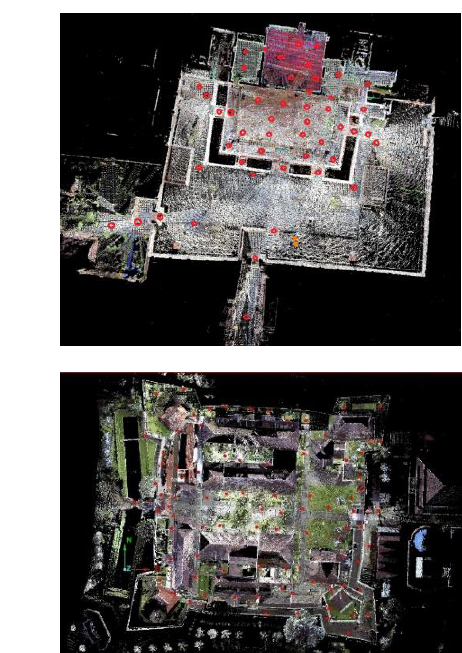
Figure 5. Terrestrial Lidar’s scan station at Kotagede Great Mosque Building (a) and Vredeburg Fort Museum (b). Red circle denotes TLS scan station